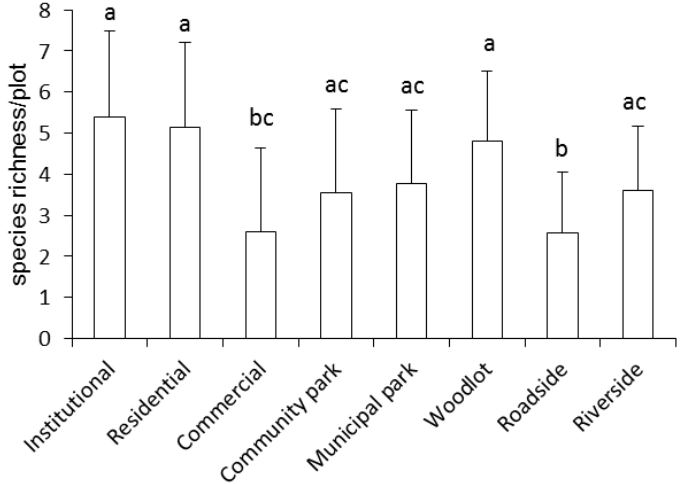
Figure 2. Ruderal species richness in different land use types (LUTs) in the built-up areas of Beijing.